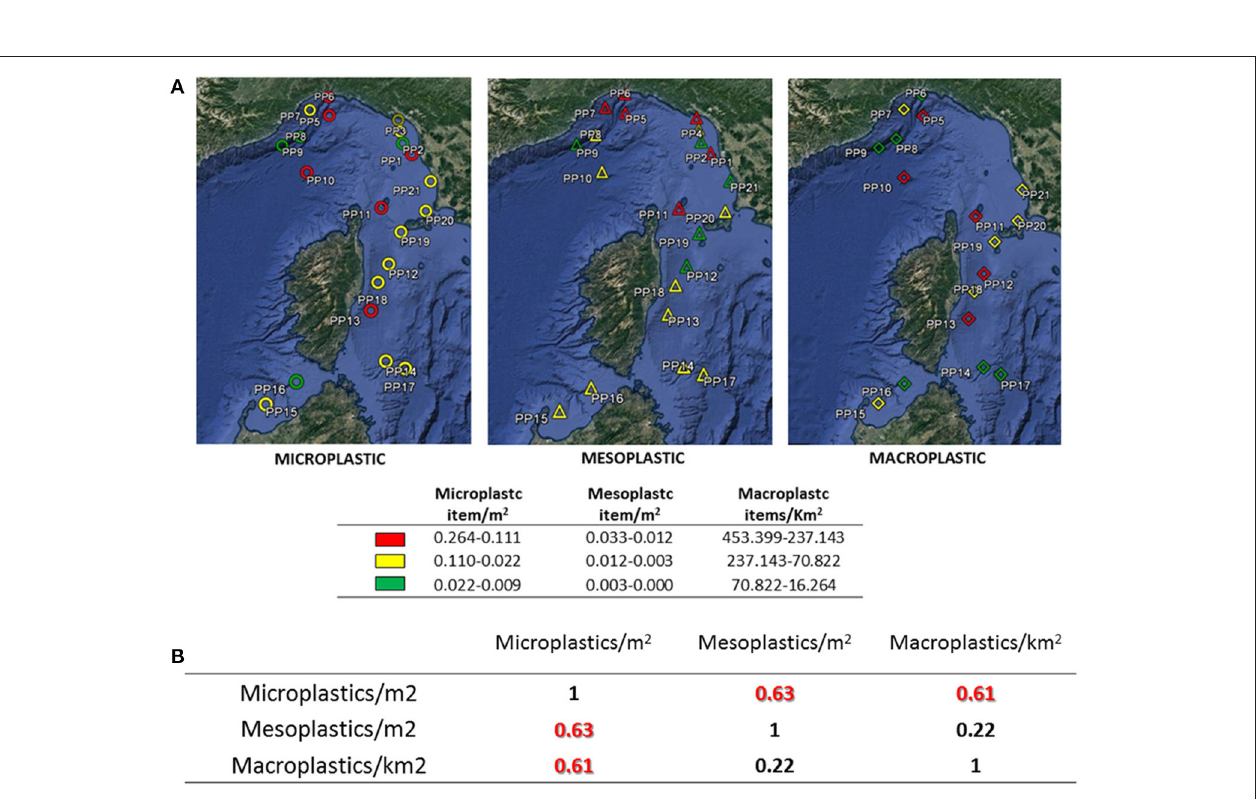
Frontiers in Marine Science | www.frontiersin.org